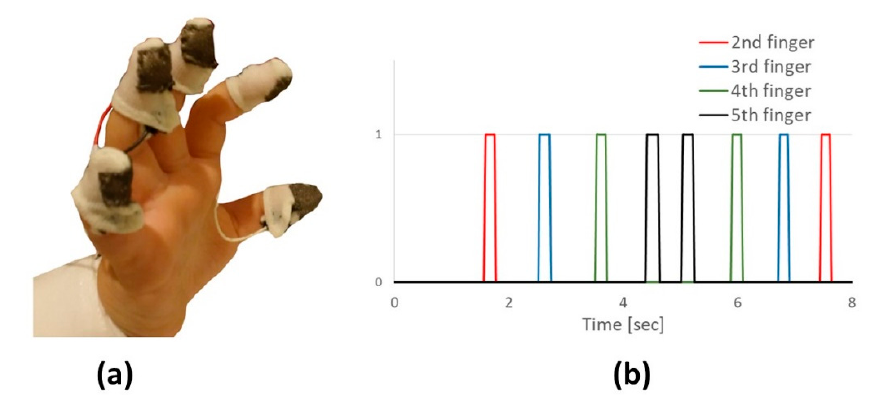
Figure 1. ( a ) The Sensorized Finger Sequencing Test (SFST) was worn on the hand of a subject. A cotton thimble was attached to each finger. A rectangle of conductive fabric was sewn onto the tip of each thimble and connected with wires to a microcontroller that was connected to a computer. ( b ) Example of raw data collected for a healthy subject. Correct finger sequencing is demonstrated over time.